Question: According to this chart, does the measure grow or shrink?
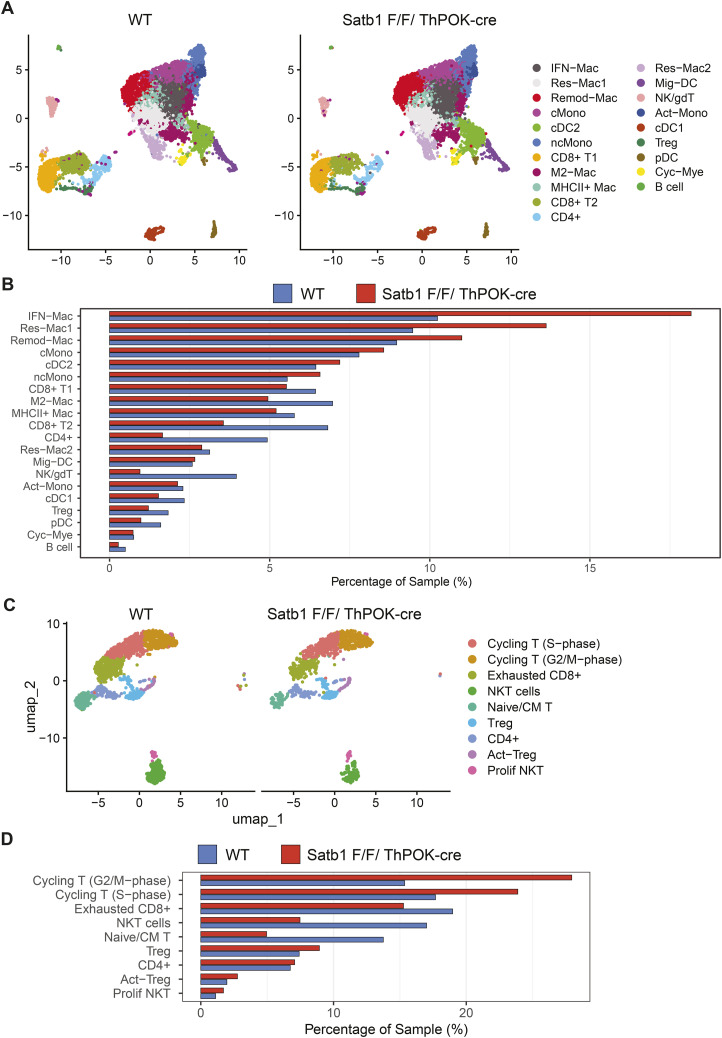
Answer: increasing